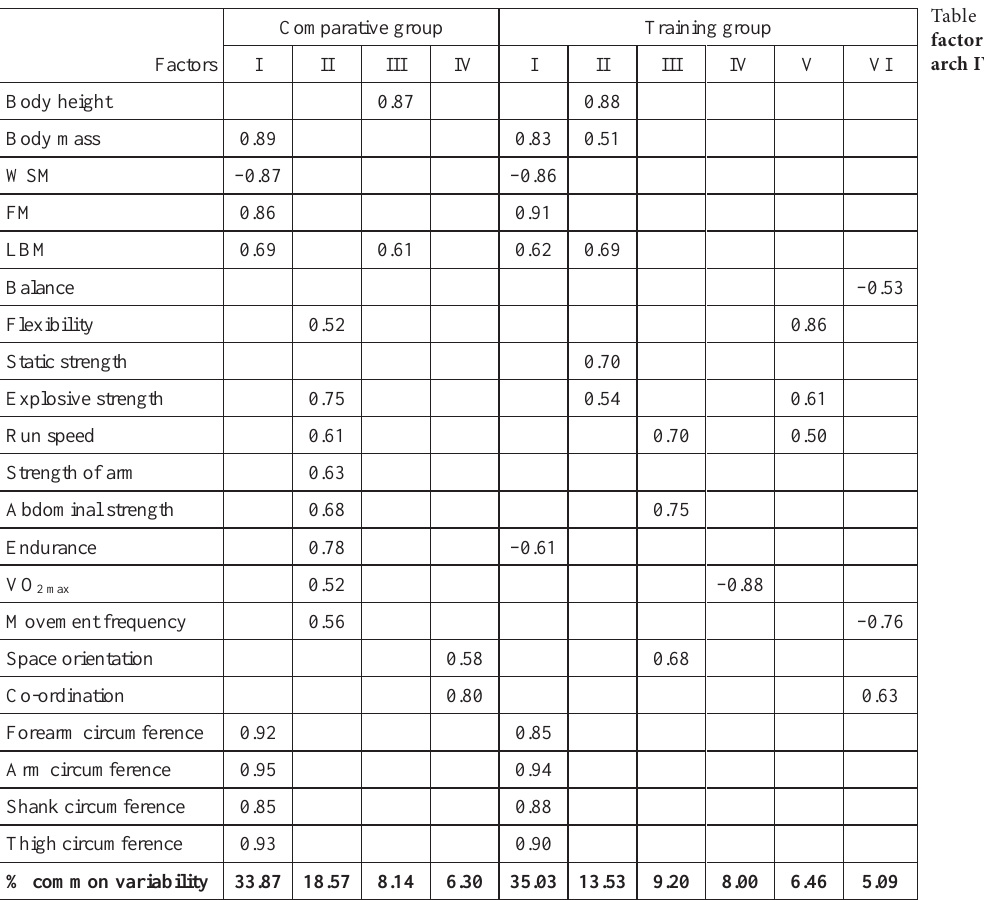
Table 8. The results of the factor analysis in the rese- arch